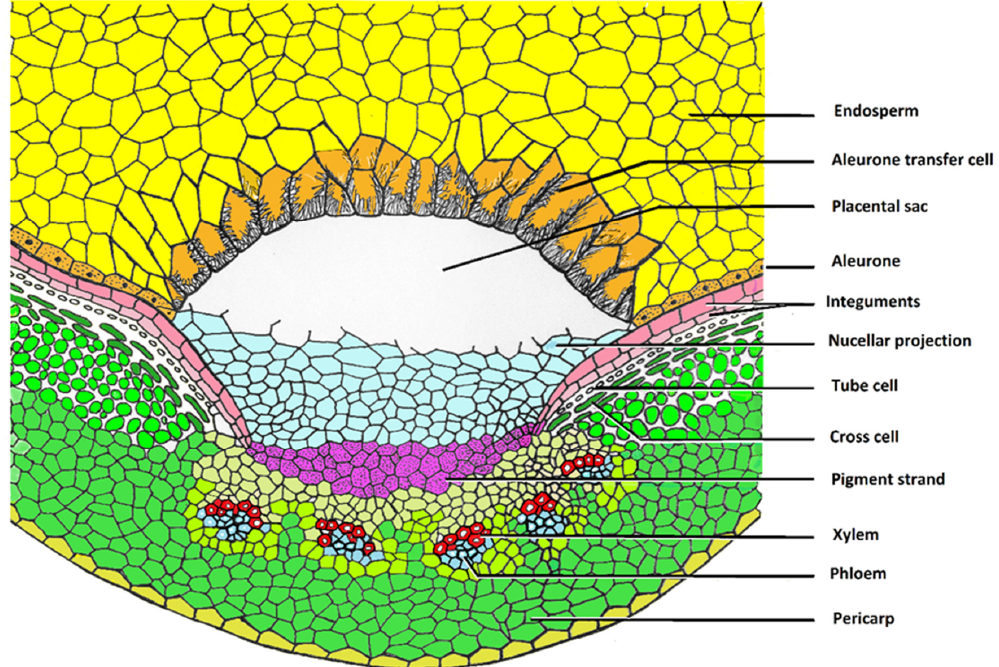
Figure 9. Diagrammatic representation of a portion of basal region of sorghum caryopsis seen in transverse section during rapid grain-filling stage (15-20 DAF) Pericarp and basal ovular vascular bundles are shown. Chalazal region has differentiated into pigment strand